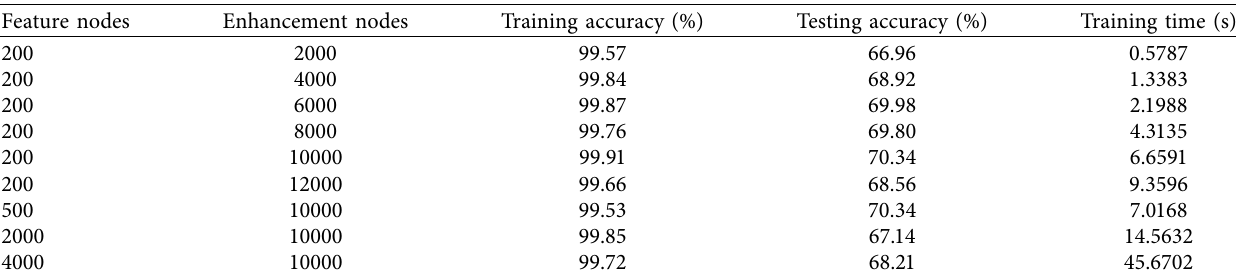
Figure 4: Feature extraction of ECT reconstructed images. (a) Reconstructed gray-scale image. (b) Reconstructed binary image. Table 1: The result of BLS.